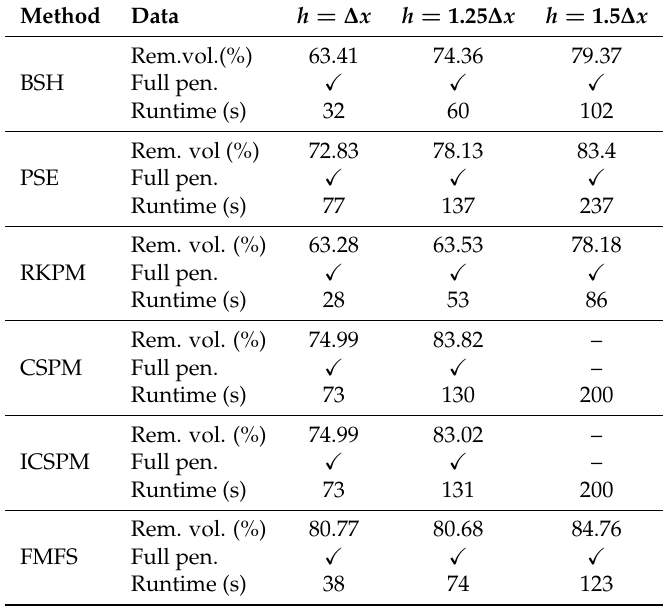
Table 3. Batch 1: Coarse discretization using a total of 27k particles with the cubic B-spline kernel.